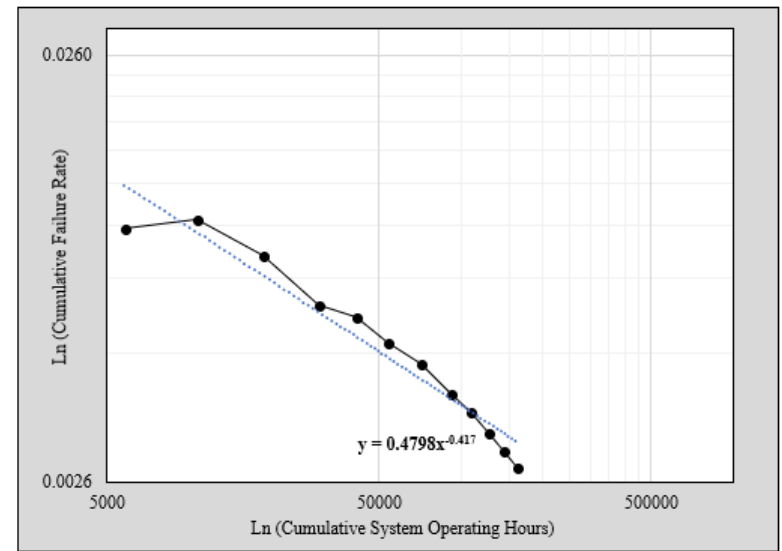
Figure 2. Plot of cumulative failure rate vs. cumulative system operating hours on log-log axes